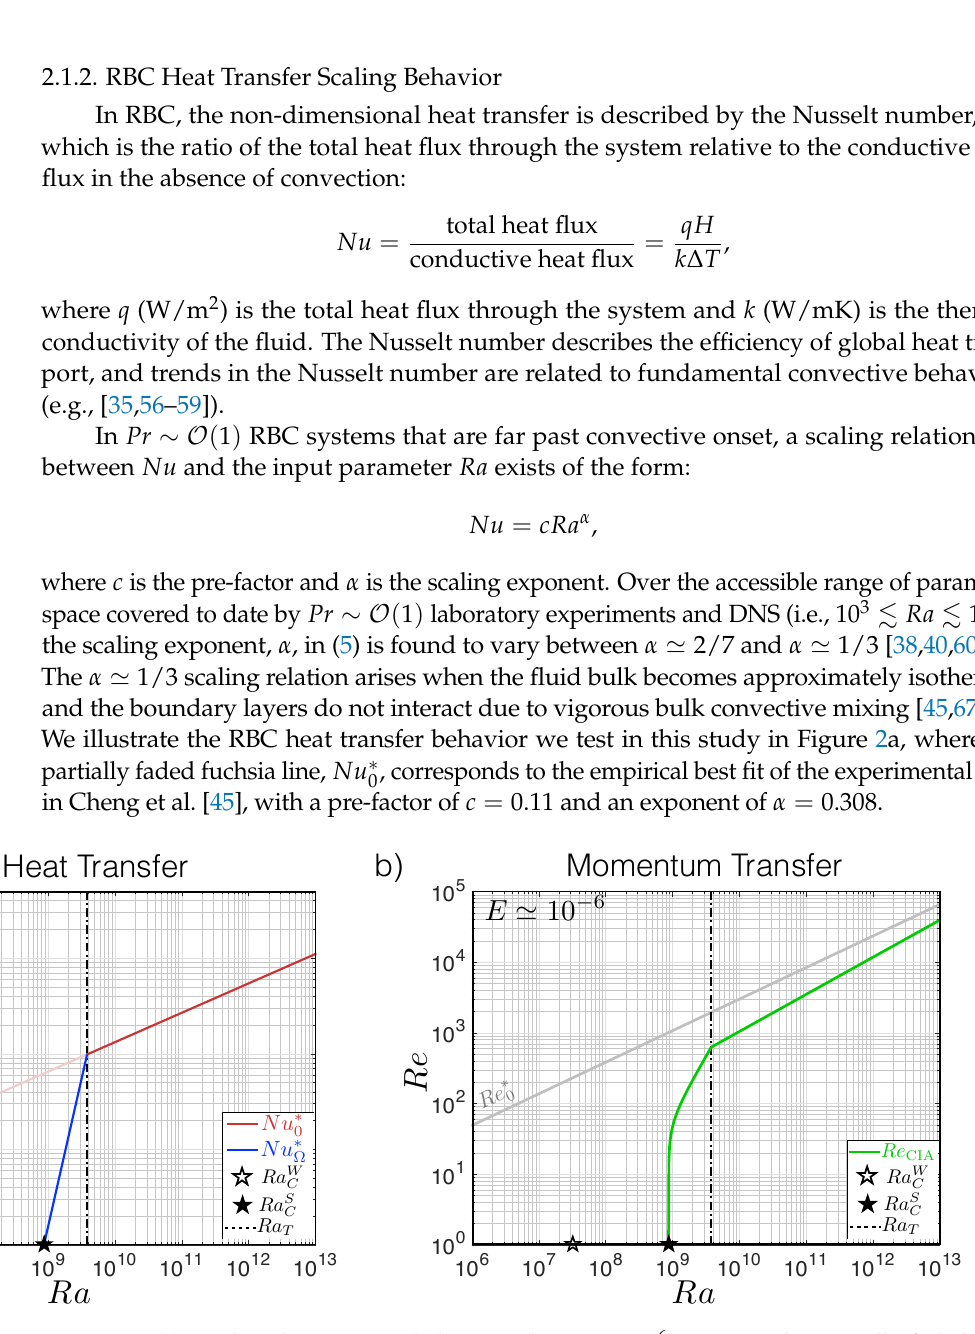
Figure 2. ( a ) Predicted Nu vs. Ra behavior when E 10 − 6 , Pr 6. The partially faded fuch- (cid:39) (cid:39) = 0.11 Ra 0.308 , corresponds to RBC behavior [45]. For RRBC, the solid blue line, sia line, Nu ∗ 0 ) β , where β = Nu ∗ Ω = ( Ra / Ra S 0.45 0.58 log 10 ( E ) , is valid below the empirically defined transi- C − − tion Rayleigh number, Ra T (dashed line) [3]. The open star denotes the onset of wall mode convection, Ra W 31.8 E − 1 , and the solid star denotes the onset of steady convection, Ra S 8.7 E − 4/3 [75,76]. C (cid:39) C (cid:39) When Ra > Ra T , heat transfer is expected to return to the non-rotating scaling given by Nu ∗ 0 = 0.102 Ra 0.447 is the (fuchsia). ( b ) Predicted Re vs. Ra behavior for E 10 − 6 , Pr 6. Re ∗ 0 (cid:39) (cid:39) Re CIA = ( Ra ( Nu 1 ) / Pr 2 ) 2/5 E 1/5 (green). The open and solid stars are the same as those in ( a −